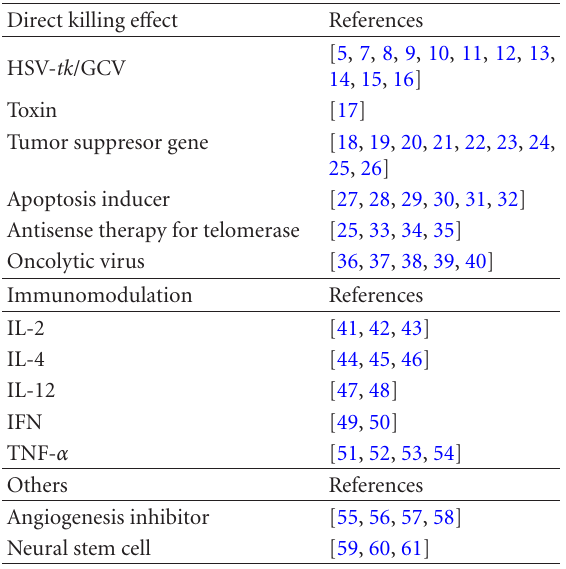
Table 1. Therapeutic